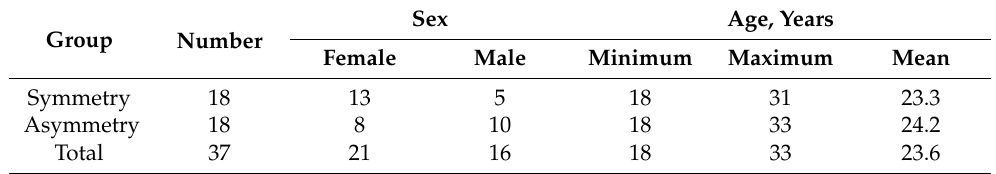
Table 2. Descriptive data of the two groups of patients.